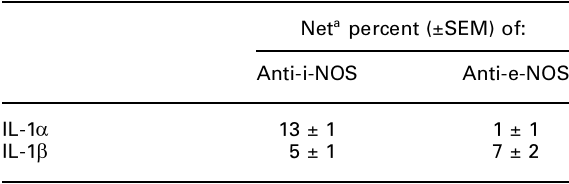
Table 1. Differential induction of i- and e-NOS by IL-1 a and IL- 1 b on RIN-5AH